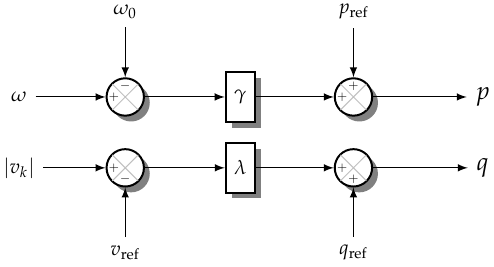
Figure 1. Block diagram for the primary droop control.